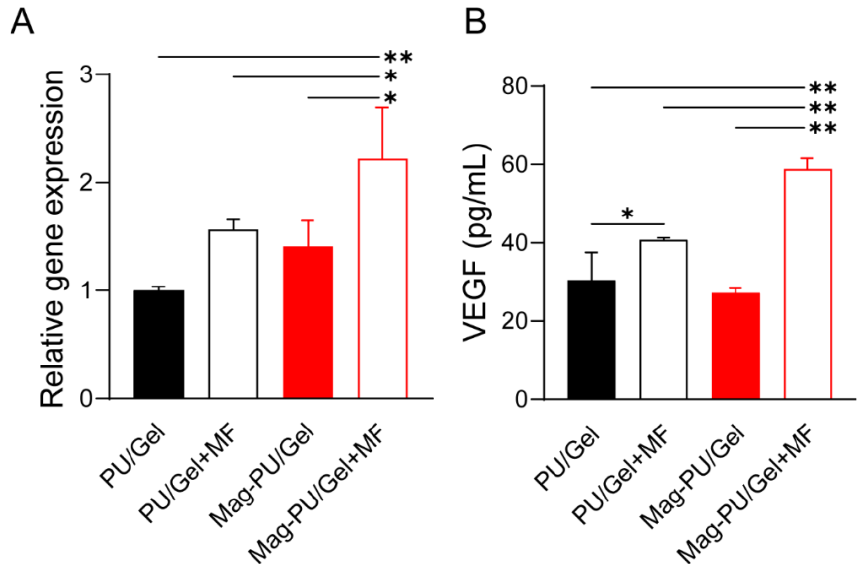
Figure 5. Effects of magnetic scaffolds combined with the magnetic fields on VEGF production of C2C12 cells. ( A ). The relative gene expression of Vegfa normalized to PU/Gel group ( Gapdh served as reference). ( B ). Secretion of VEGF detected by ELISA. These data were analyzed by one-way analysis of variance with Tukey’s post hoc test: * p < 0.05, ** p < 0.01. * indicated significant difference.